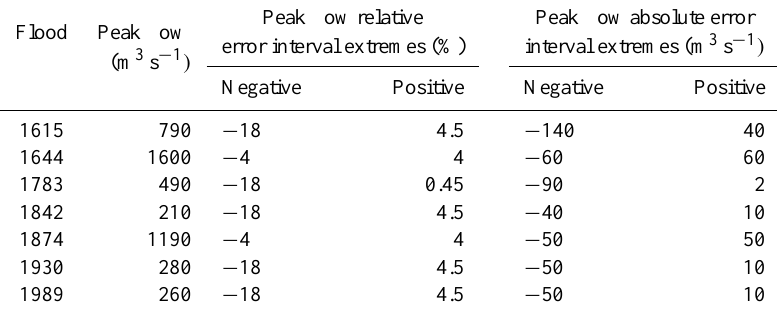
Table 5. Peak flow error intervals due to historically observed water height and Manning’s n . (Precision of the historically observed water height was 0.5cm when obtained from limnimarks (1640, 1783 and 1874 floods) and 5cm when obtained from other historical sources (1615, 1842, 1930 and 1989) and Manning’s n precision was estimated as 25% in all cases; accordingly to the sensitivity analyses, the relative error of the peak flow due to a 5cm error in historically observed water height was 4.5%, and that due to a 10% increase in Manning’s n was − 1.5% for high peak flows and − 7% for low peak flows and 1.5% and 0%, respectively, for a 10% decrease in Manning’s n ; 1000m 3 s − 1 was the limit chosen between high and low peak flows). Peak flow relative Peak flow absolute error Flood Peak flow error interval extremes (%) interval extremes (m 3 s − 1 ) (m 3 s − 1 ) Negative Positive